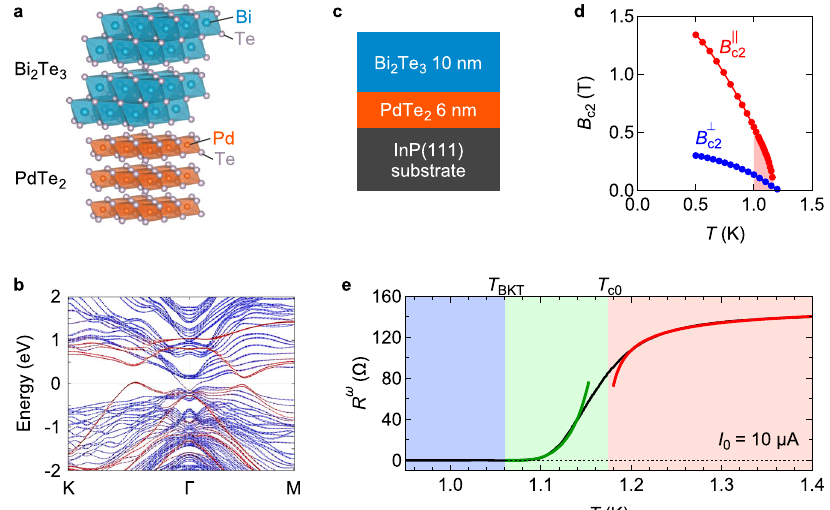
Fig. 1 Electronic structure and superconductivity of Bi 2 Te 3 /PdTe 2 heterostructure. a Crystal structure of Bi 2 Te 3 and PdTe 2 . b Band structure of PdTe 2 (1 layer)/Bi 2 Te 3 (6 layers)/PdTe 2 (1 layer). The red and blue lines correspond to the states originating from PdTe 2 and Bi 2 Te 3 , respectively. c Schematic of the thin- fi lm heterostructure. d Temperature dependence of in-plane and out-of-plane upper critical fi elds, B k (red) and B ? (blue). Nonreciprocal transport is studied in the red-shaded parameter region. e Temperature dependence of R ω measured under c2 I 0 = 10 μ A. The red curve is the fi t by the Aslamazov – Larkin formula, Δ G ¼ e 2 T c0 = 1.174 K and R N = 153 Ω . The green curve is the fi t by the Halperin – Nelson formula R ω ¼ R c exp (cid:2) 2 b = 3.50 are material-dependent fi tting parameters, and T BKT = 1.060 K is the BKT transition temperature estimated from the power law of current – voltage characteristics (Supplementary Fig. 5). T BKT and T c0 separate the temperature into three regions: zero-resistance (blue), free vortices (green), and paraconductivity